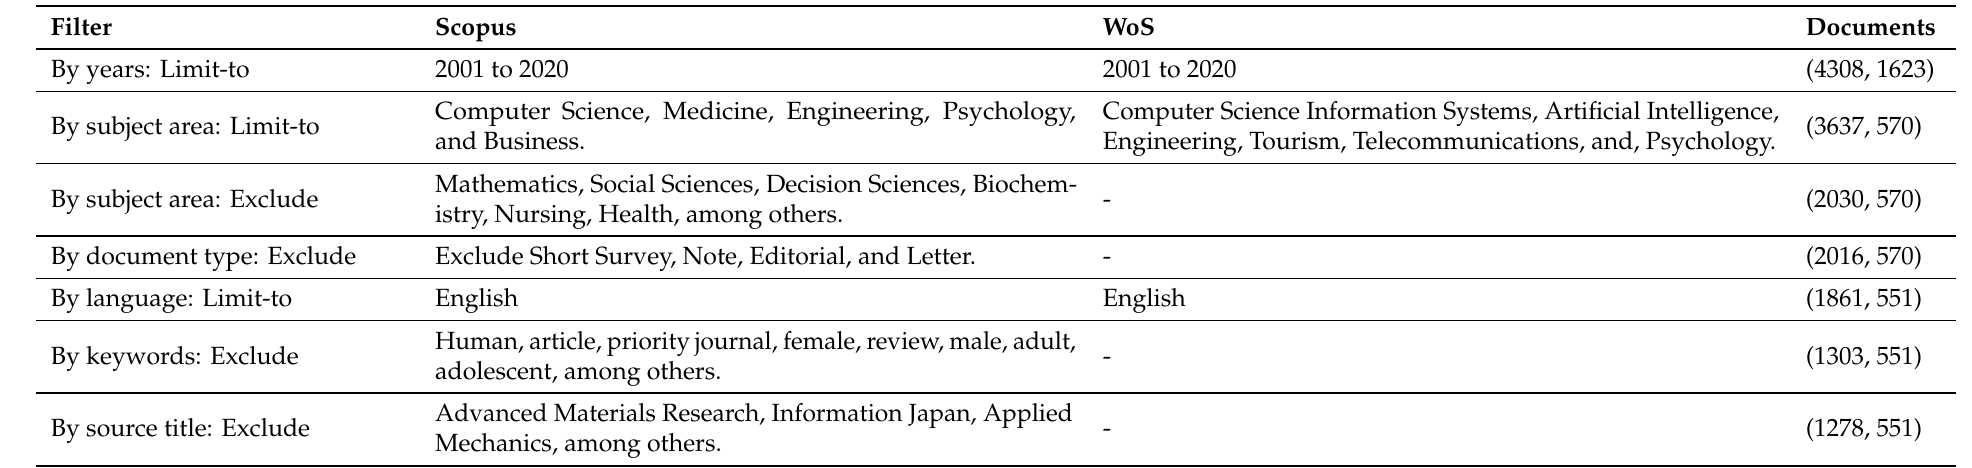
Table 1. Filters applied to the search string. The documents correspond to the WoS and Scopus